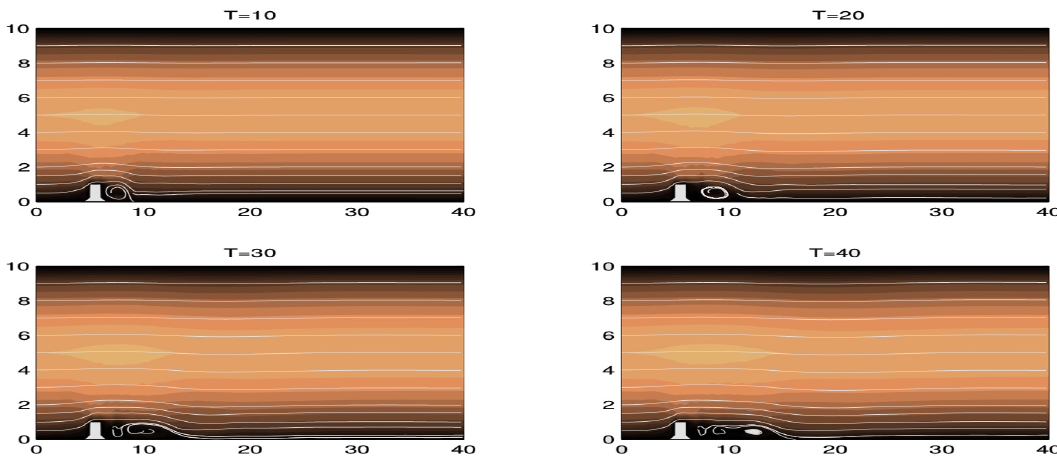
Figure 4. Four snapshots ( t = 10,20,30, and 40) of the linear time relaxation model (TRM) with deconvolution order N = 0, filter length δ = 1.5, and relaxation term χ = 0.01. Shown are streamlines overlaid above speed contours | v h ( x , t ) | . Lighter shades represent higher speeds. This figure was originally published in